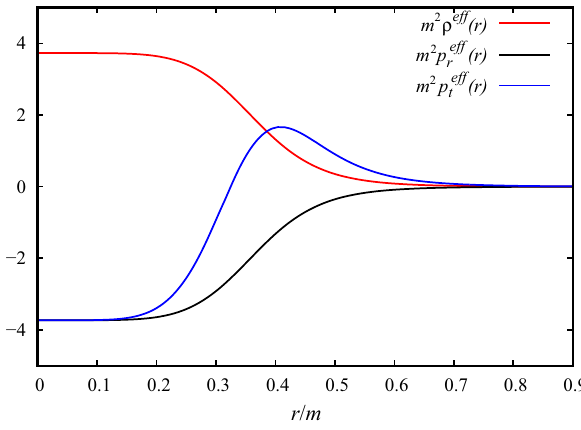
Fig. 6 Graphical representationofthe fluid quantitiesfor mc 1 = 1and q = 0 . 4